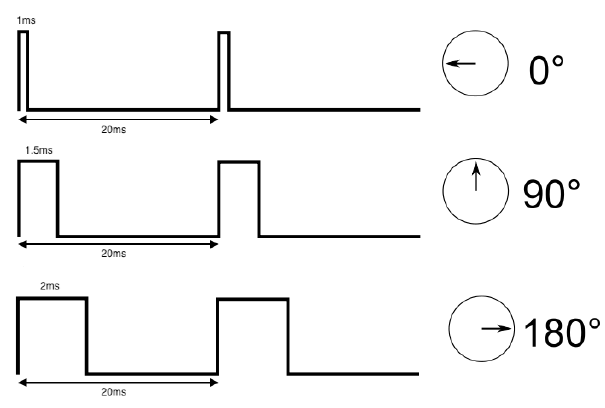
Figure 1. Example of the relation between the duty-cycle of the square control signal and the degree of rotation of a Pulse Width Modulation (PWM) servomotor.